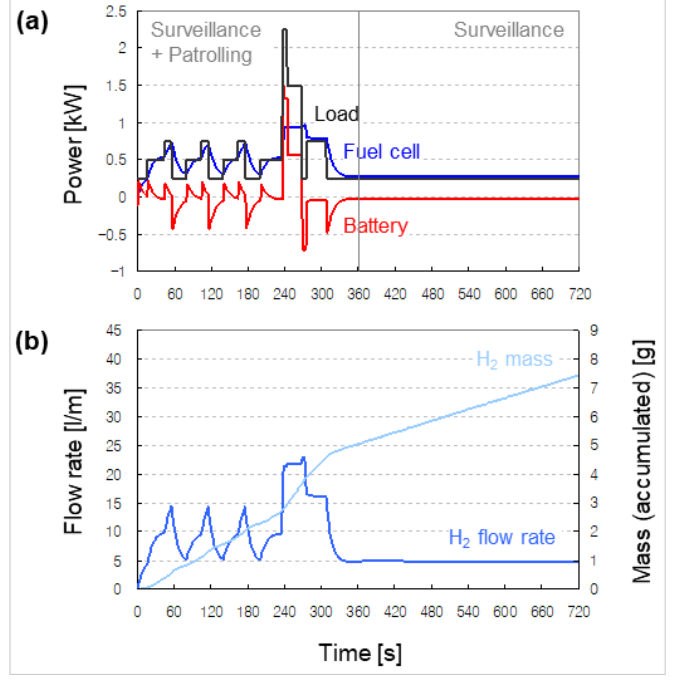
Figure 12. Simulated ( a ) power and ( b ) hydrogen flow rate with accumulated mass of HPS throughout a full cycle (until 720 s).